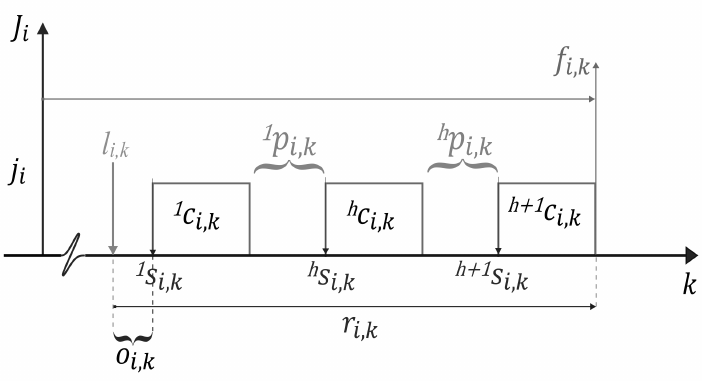
Figure 5. Scheme of timing constraints for an instance j i , k of a task J i . The timing constraints involve the arrival time l i , k , start time s i , k , preemption time p i , k , computing time c i , k and end time f i , k , letter h represents the segment number of each